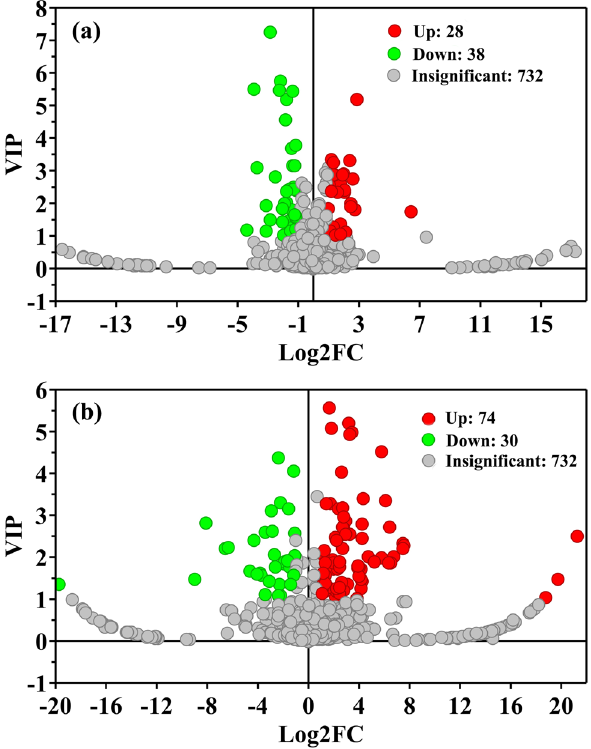
Figure 4: Volcano maps of the di ff erential metabolites in the com - parisons of LS1 vs LS2 ( a ) and LS2 vs LS3 ( b )